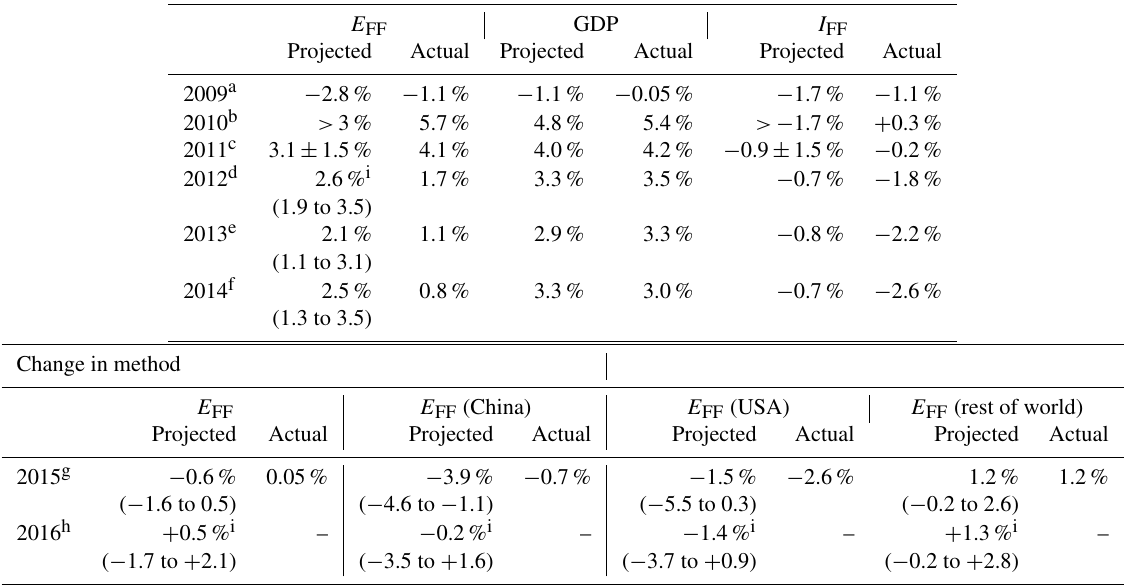
Table 9. Actual CO 2 emissions from fossil fuels and industry ( E FF ) compared to projections made the previous year based on world GDP (IMF October 2015) and the fossil fuel intensity of GDP ( I FF ) based on subtracting the CO 2 and GDP growth rates. The “Actual” values are the latest estimate available and the “Projected” value for 2016 refers to those presented in this paper. No correction for leap years is applied (Sect.